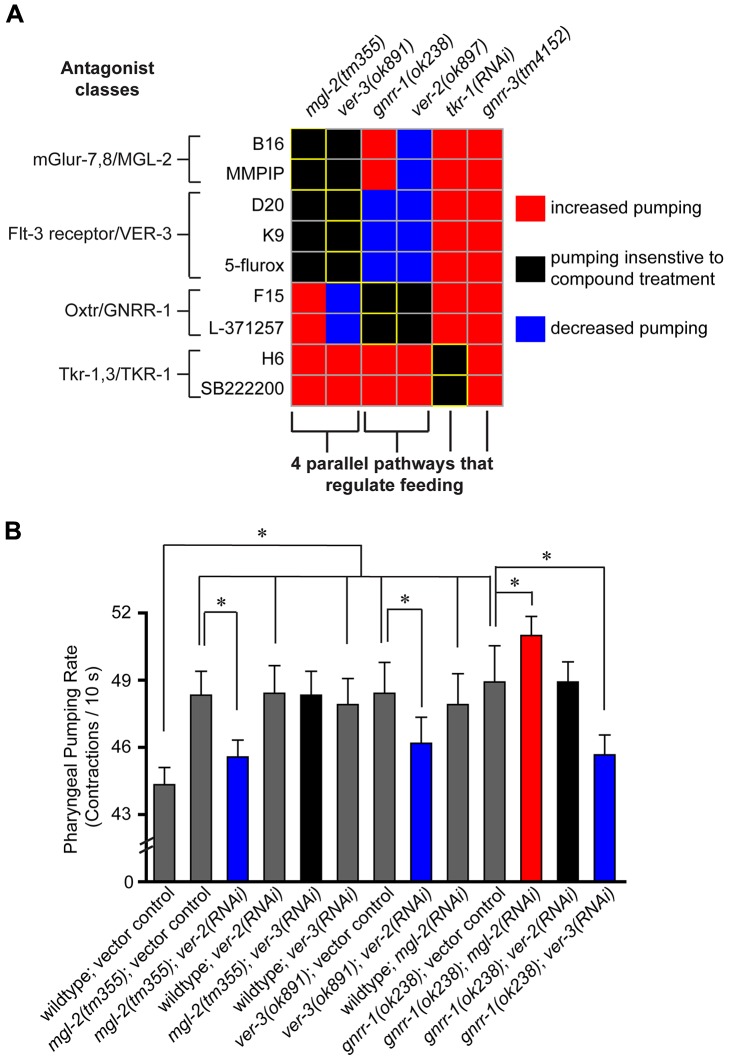
Interaction matrix of all binary combinations of compounds and gene knockdowns that individually increase pharyngeal pumping.(A) The differences in the pumping rates of compound-treated versus vehicle (0.1% DMSO) treatment on each genetic background for all pair-wise combinations of compounds and mutants were evaluated. Compound concentrations used were 10 µM for B16, D20, K9, F15, and H6; 200 nM for L-371257 and SB 222200; and 2 µM for MMPIP, 5-flurox. The predicted compound–target interactions are outlined in yellow. Red- and blue-labeled interactions indicate pumping rates significantly different (ANOVA, p<0.05 Dunnett's multiple comparison test) from the corresponding vehicle control-treated mutant. (B) The implied genetic interactions on pharyngeal pumping of mgl-2, ver-2, ver-3, and gnrr-1 mutants assayed by mutant–RNAi combinations. Twelve animals per condition were analyzed. Error bars represent 1 standard deviation. * p<0.001 one-way ANOVA using Bonferroni's multiple comparison test.